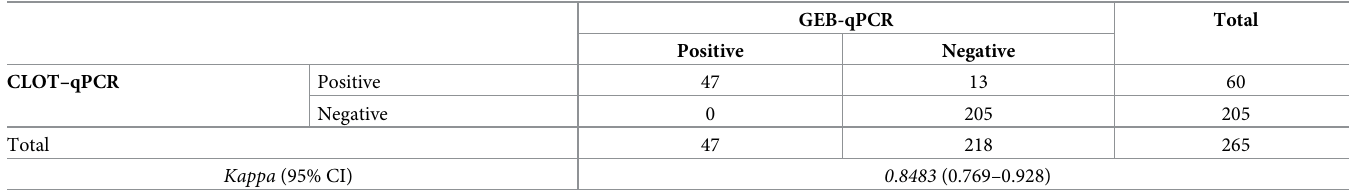
nique described here still depends on the use of GE for DNA extraction. Guanidine is a chao- tropic agent that helps to disrupt the clot and the cell membranes, and solubilizes the DNA. Other home-made and commercial buffers to disrupt the clot have been tested by us with results that were not comparable to the ones obtained using GE. By using DNA extracted from clot, the sensitivity of the qPCR is increased as reflected by the low Cq values obtained in comparison to the Cq values obtained using DNA extracted